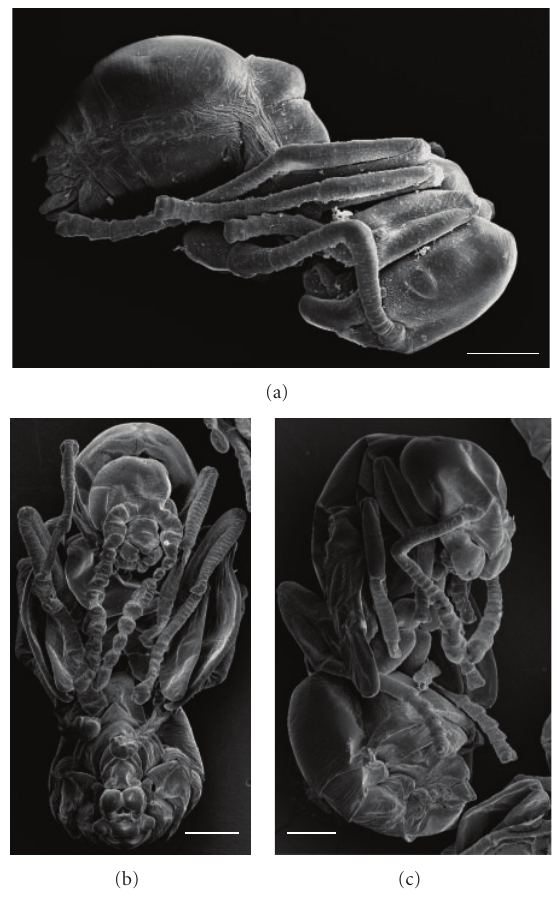
Figure 7: Pupae of major worker (a), male (b), and gyne (c) of Solenopsis saevissima. Respective sizes of scale bars ( µ m): 300, 500, and 500.